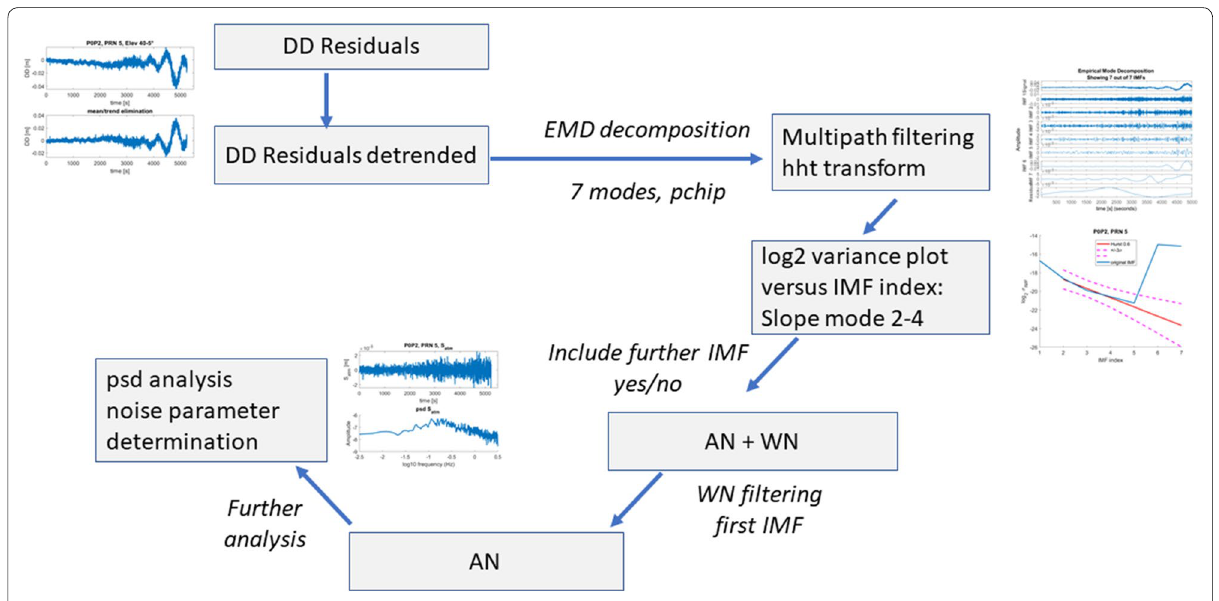
Fig. 3 The methodology to extract an AN in three